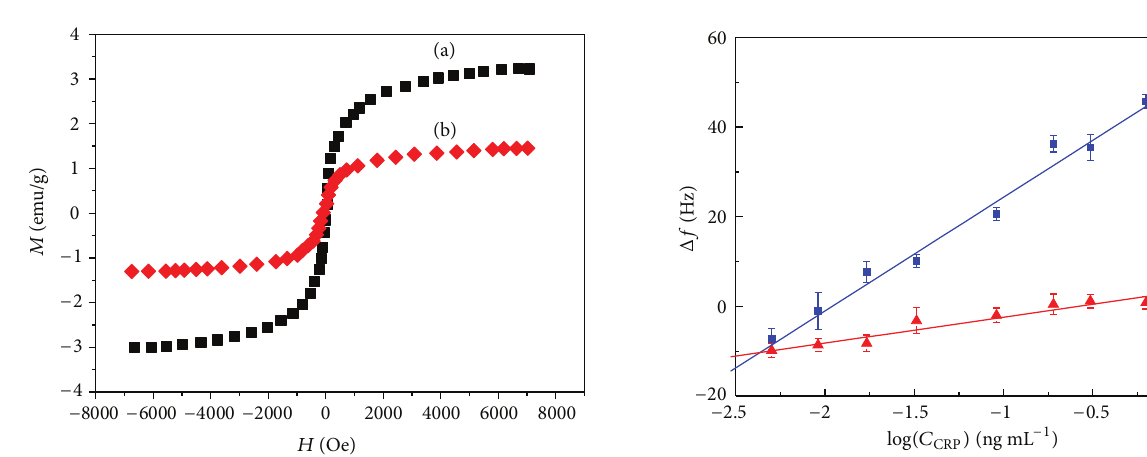
Figure 4: Hysteresis loops of magnetic silica nanospheres with (a) Fe 3 O 4 -NH 2 and (b) Fe 3 O 4 @SiO 2 @Au at 300K, respectively.